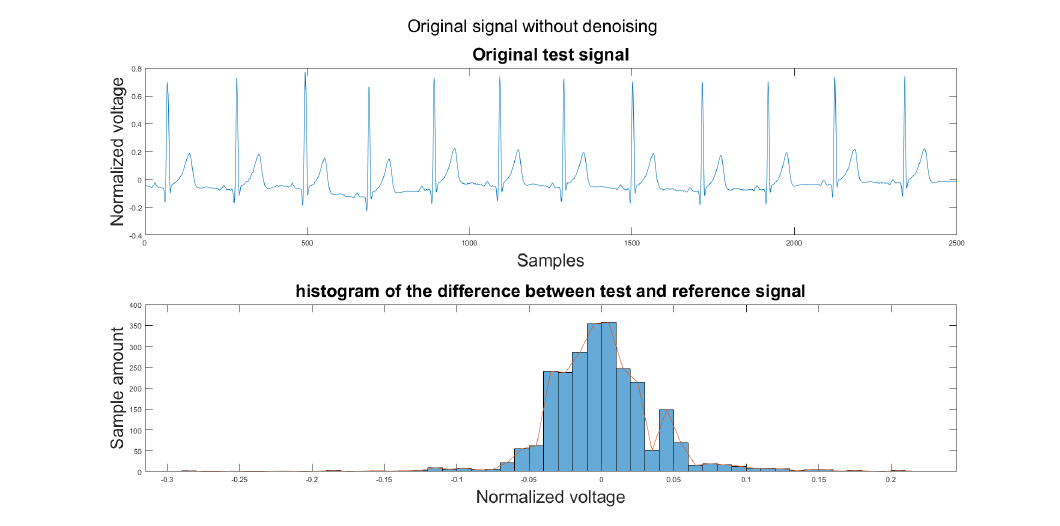
Figure 13. (1) Clean example signal, (2) histogram of the